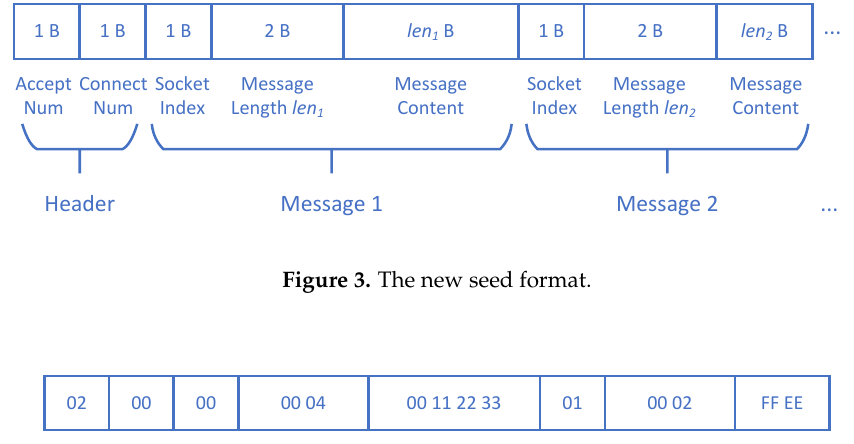
Figure 4. An example seed in the new format (hex